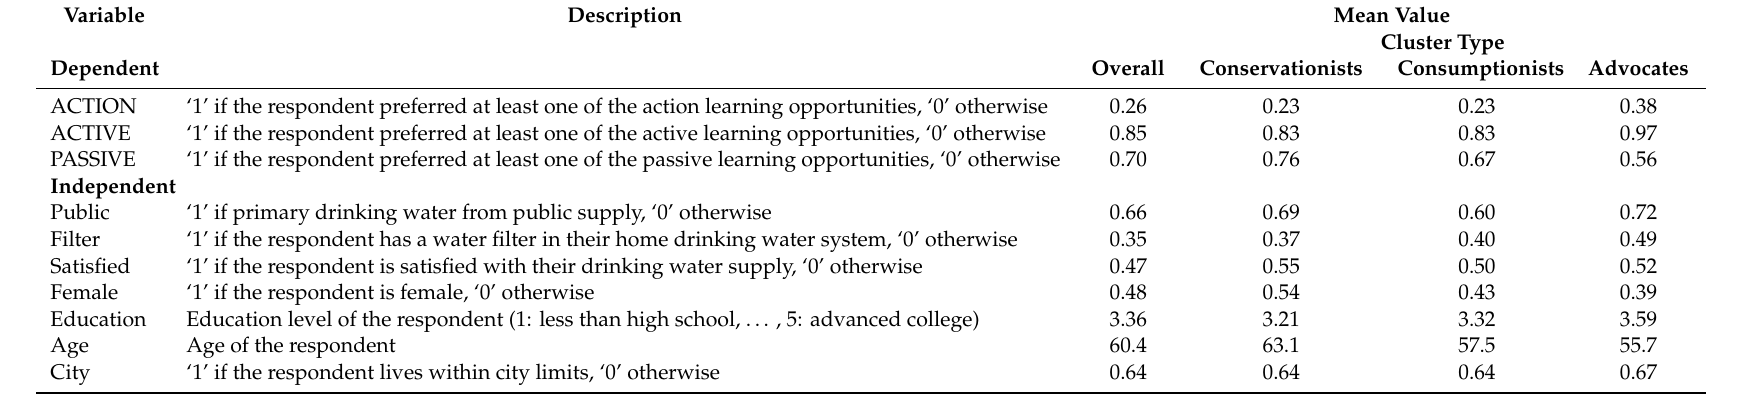
Table 3. Descriptive statistics of variables by cluster type ( n =